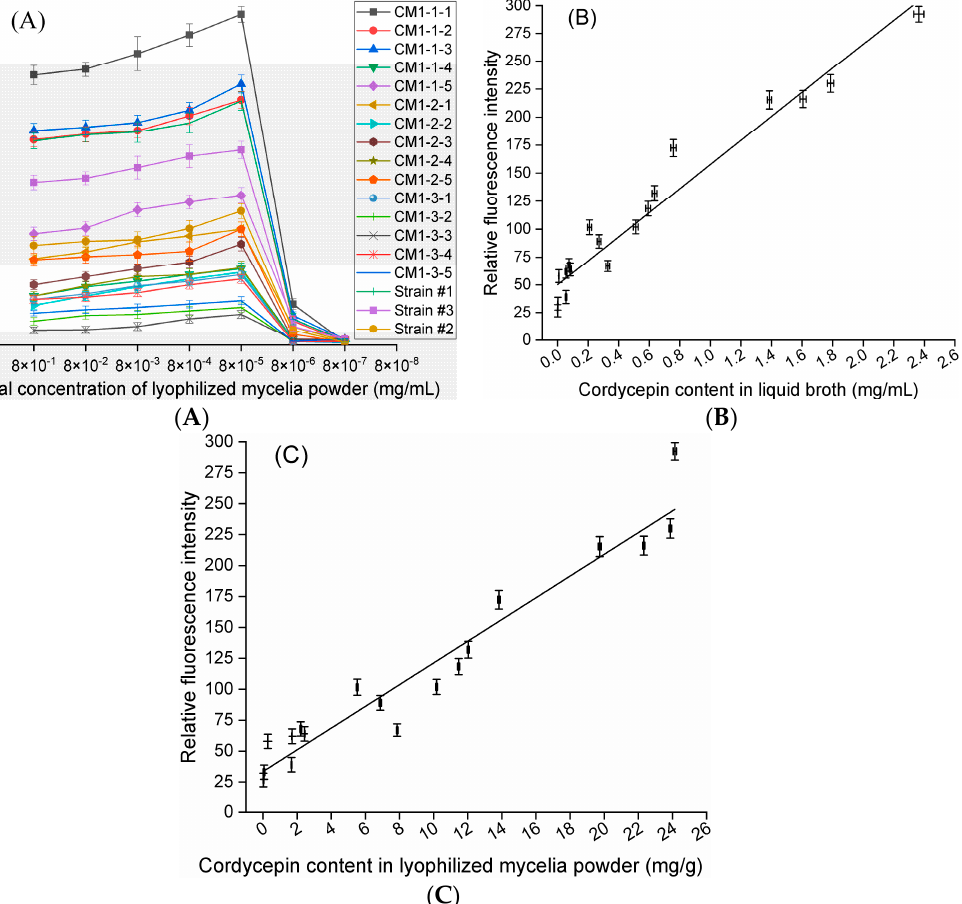
Figure 4. Relative fluorescence intensities from Nile red-stained lyophilized mycelium powder of six strains and corresponding cordycepin concentration in liquid broth. ( A ) Relative fluorescence intensities from 18 strains at different concentrations. ( B ) The relative fluorescence intensities of 8 × 10 − 5 mg/mL lyophilized mycelium powder of 18 strains are linearly correlated with the corresponding cordycepin concentration in liquid broth (R 2 = 0.9514). ( C ) The relative fluorescence intensities of 8 × 10 − 5 mg/mL lyophilized mycelium powder of 18 strains are linearly correlated with the corresponding cordycepin content in lyophilized mycelium powder (R 2 = 0.9378).